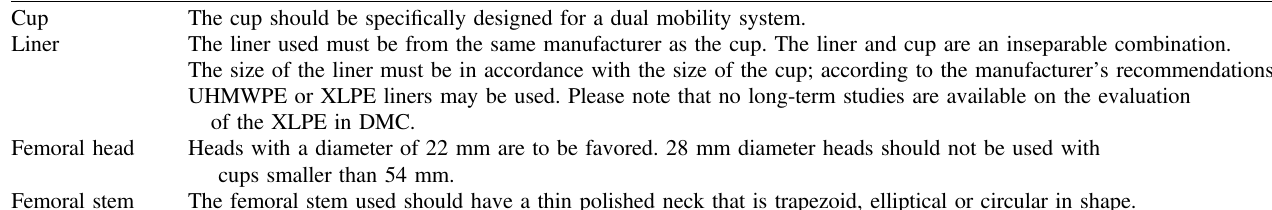
Table 2. Tips and tricks for implant compatibility